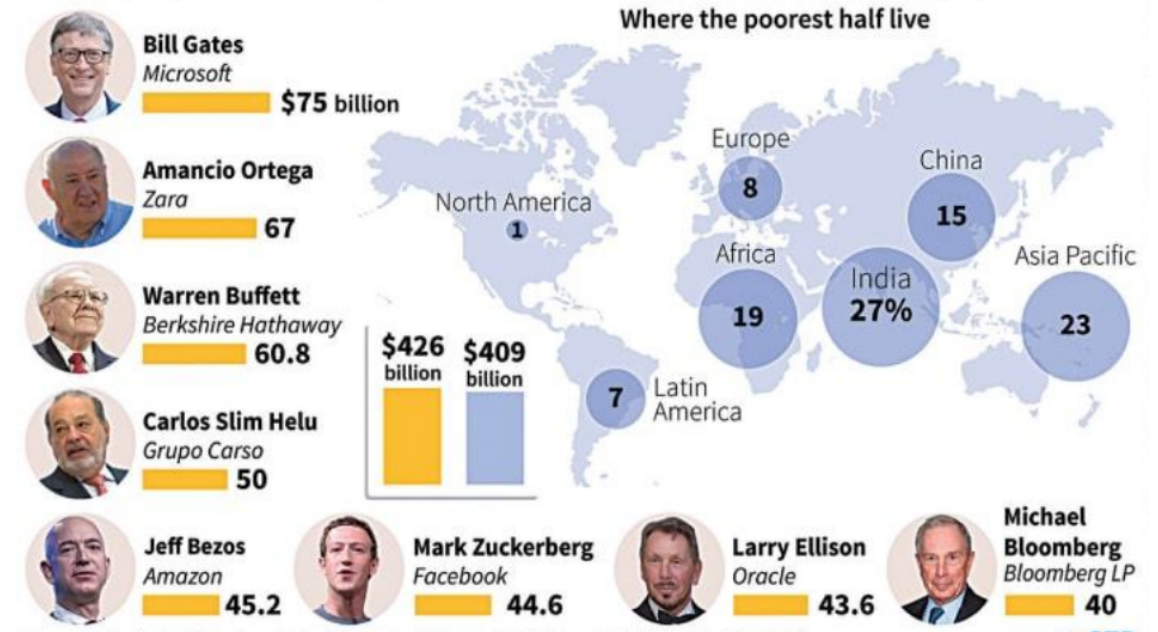
Fig. 7 . Eight men, own more wealth than the poorest half of the world’s population 43 according to (2018) calculations 44 from Oxfam based on a 2017 report 45 from Credit